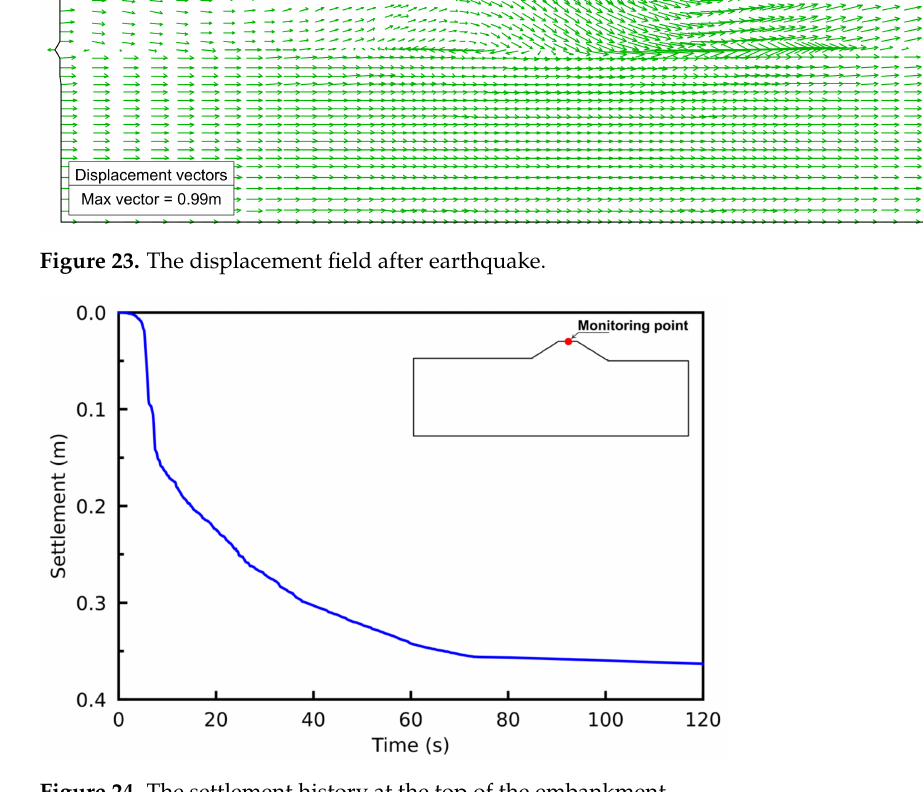
Figure 24. The settlement history at the top of the